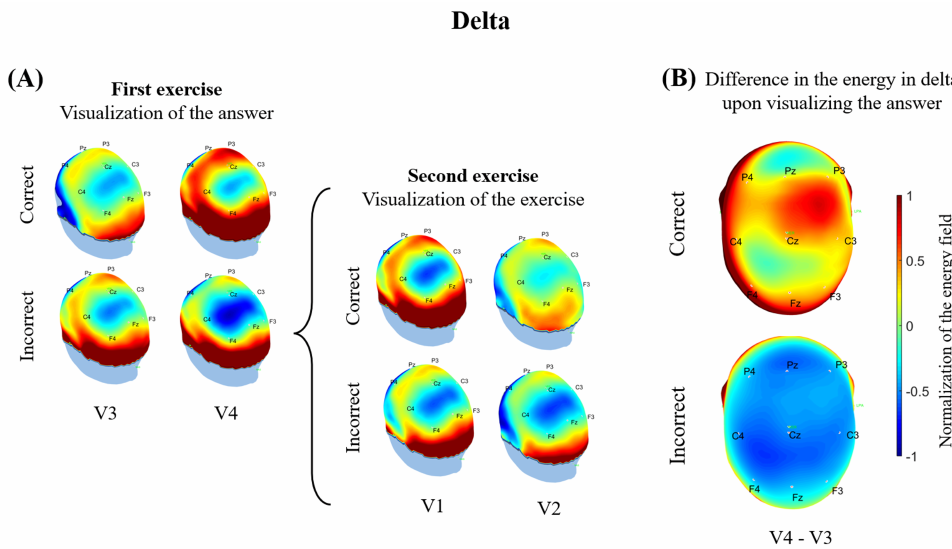
Figure 8. Relative energy of the delta band. EEG activity of the delta band in the central region. ( A ) Representation of delta brain activity at the moment of visualizing (i) the first correct vs. incorrect response, and (ii) the second response after the incorrect response; ( B ) representation of the difference in V4–V3 delta brain activity, where a positive change in energy is observed at the visualization of a correct response. The right representation shows a negative change in energy upon visualizing an incorrect